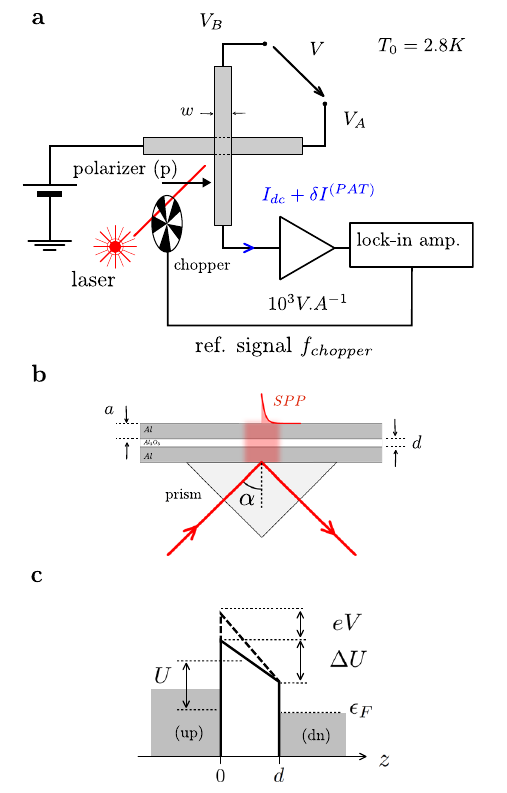
Fig. 1 Experimental setup. a Measurement setup used to study the photon- assisted tunneling induced by a laser illumination at infrared frequencies. b We consider a Kretschmann con fi guration where a right-angle prism allowed to enhance the coupling between the tunneling current and the light via the excitation of surface plasmons. c The tunnel barrier is modeled by a trapezoidal barrier.